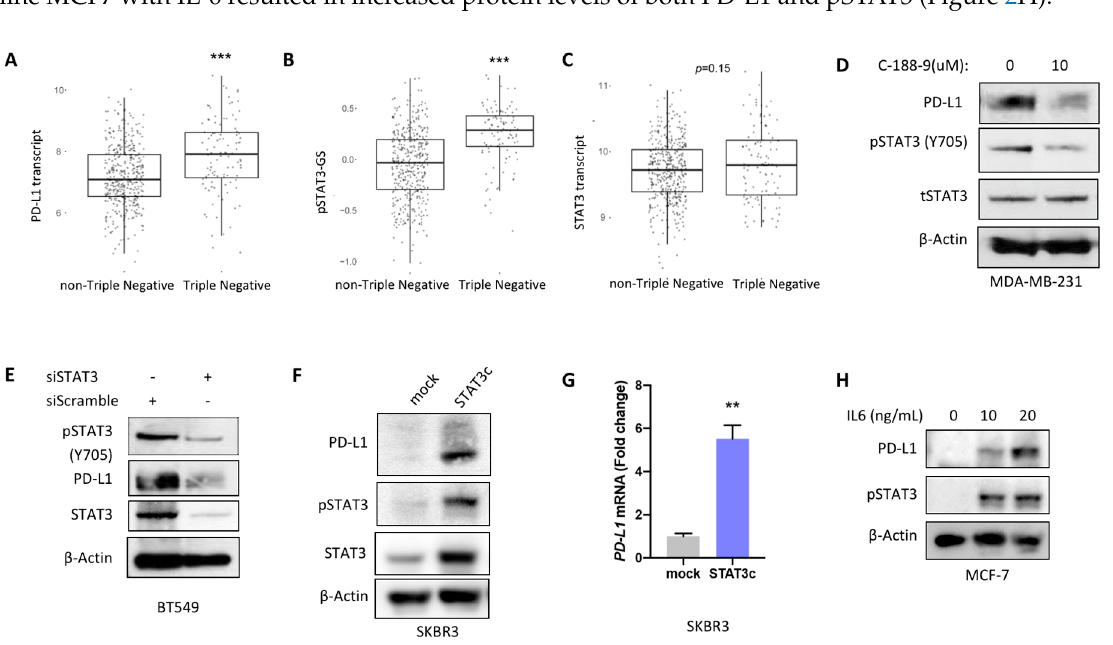
Figure 2. Expression patterns of STAT3 and PD-L1 in human breast cancer subtypes and regulation of PD-L1 by STAT3 in breast cancer cell lines. ( A ) Expression levels of PD-L1 transcript, ( B ) pSTAT3-GS score and ( C ) STAT3 transcript in triple-negative versus non-triple negative breast cancer patients. ( D ) Inhibition of STAT3 activity by using STAT3 inhibitor C-188-9 (XIII) resulted in decreased levels of PD-L1 expression in immunoblot 48 h following treatment in MDA-MB-231 breast cancer cell line. ( E ) Knocking down STAT3 using specific siRNA construct led to decreased levels of PD-L1 in the transiently transfected BT549 cell line. Stable transfection of SKBR3 breast cancer cell line with a STAT3 overexpressing plasmid (STAT3c) resulted in increased levels of PD-L1 ( F ) protein and ( G ) transcript expression. qPCR data are illustrated as the fold change relative to control and normalized to β -actin. They represent one out of three independent experiments and are depicted as the mean ( ± standard error of the mean, SEM; ** p < 0.01). ( H ) Increased protein levels of PD-L1 were noted in MCF7 cell line in response to treatment with IL-6.